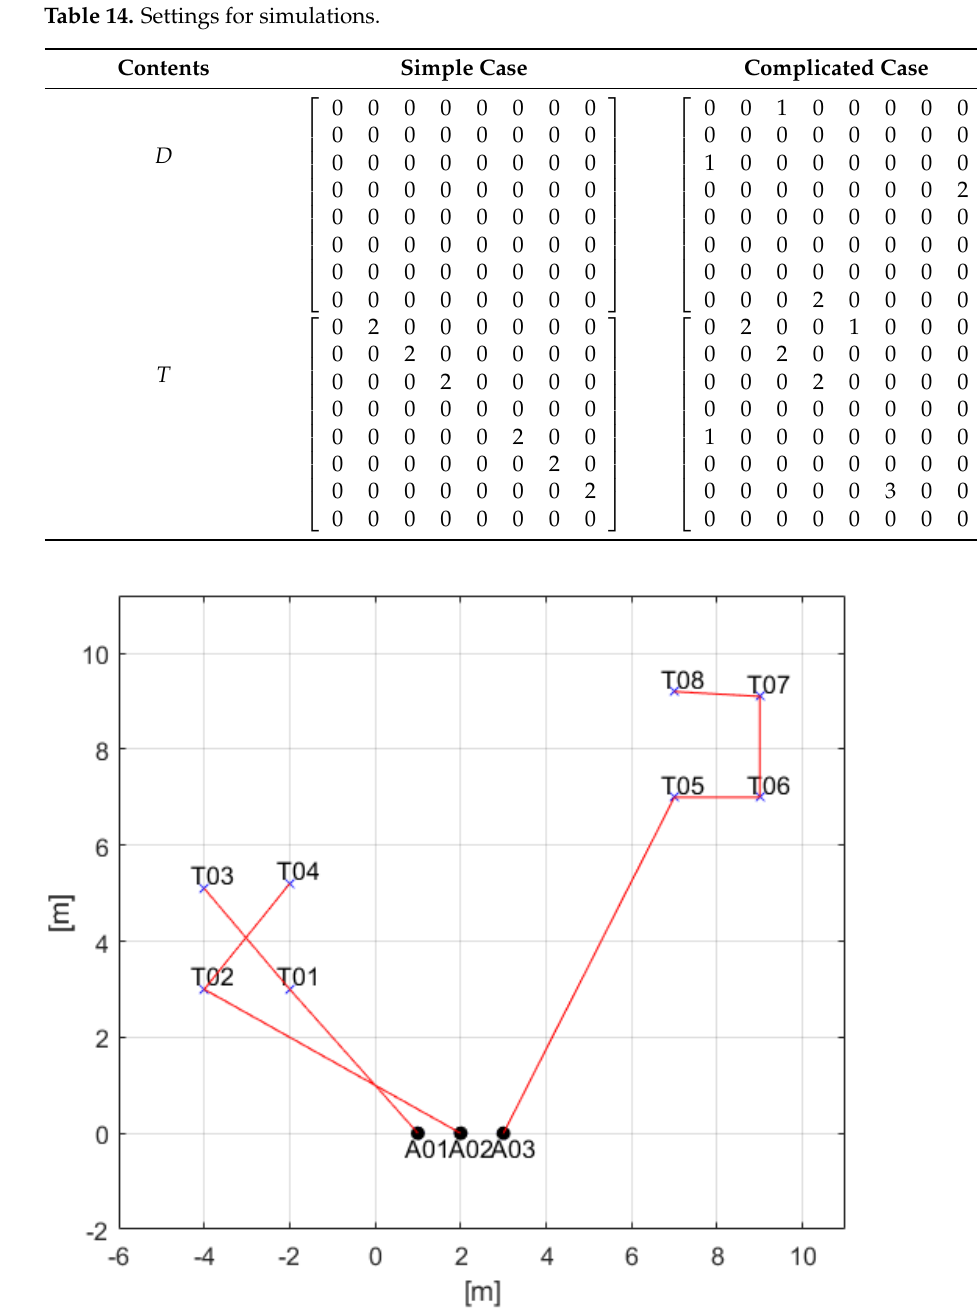
Figure 1. 2-D result of TACTAR for a simple case applying a modified time-discounted reward scheme.